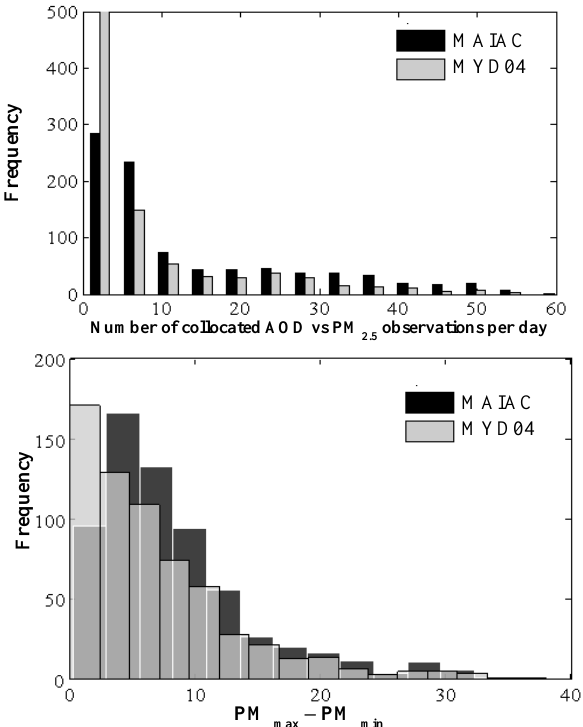
Fig. 8. Top: distribution of the number of available collocated Figure 8. Top: Distribution of the number of available collocated AOD - PM 2.5 pairs per day AOD–PM 2 . 5 pairs per day based on 1km MAIAC (black) and 10km MYD04 (grey) retrievals. Bottom: distribution of the daily based on 1km MAIAC (black) and 10km MYD04 (grey) retrievals. Bottom: Distribution of the difference between maximal and minimal measured PM 2 . 5 for col- located AOD pairs on a given day based on 1km MAIAC (black) and 10km MYD04 (grey) retrievals.